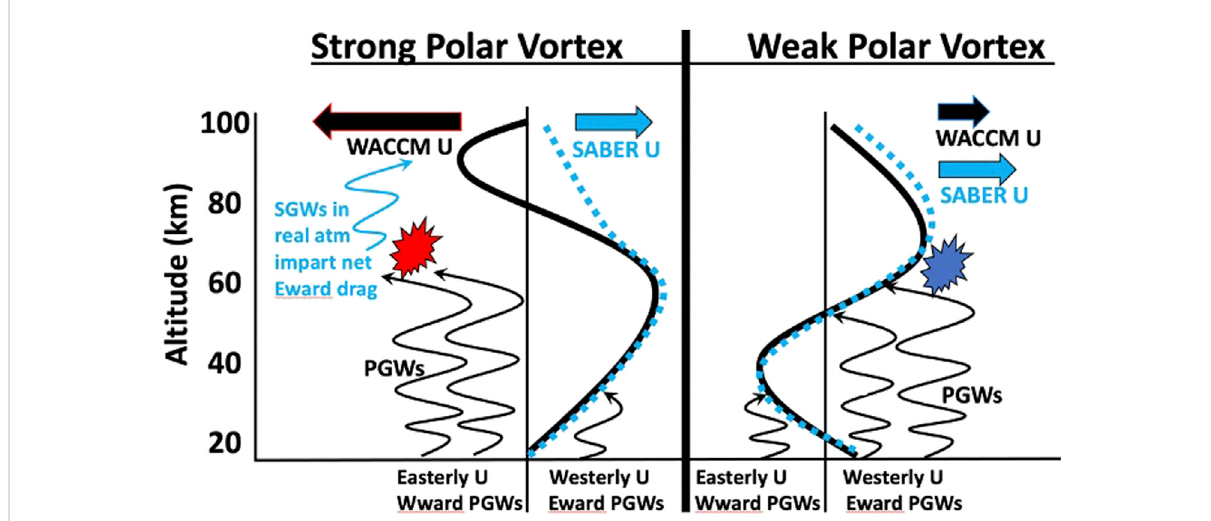
FIGURE 2 Schematicillustrating zonal windsand GWprocesses that modulate theeasterlymodel windbias intheMLT whenthevortex isstrong(left)and weak (right). Typical WACCM zonal wind pro fi les are given in thick black lines. Sounding of the Atmosphere using Broadband Emission Radiometry (SABER) observed zonal wind pro fi les are given in blue dashed lines. GWs with phase speeds opposite to the zonal wind propagate upward and dissipate. Thered(blue)stardenoteswestward (eastward)GWdragduetothebreakingofwestward (eastward)primaryGWswhenthevortexis strong (weak) and zonal winds in the stratosphere are eastward (westward). PGW = Primary Gravity Wave. SGW = Secondary Gravity